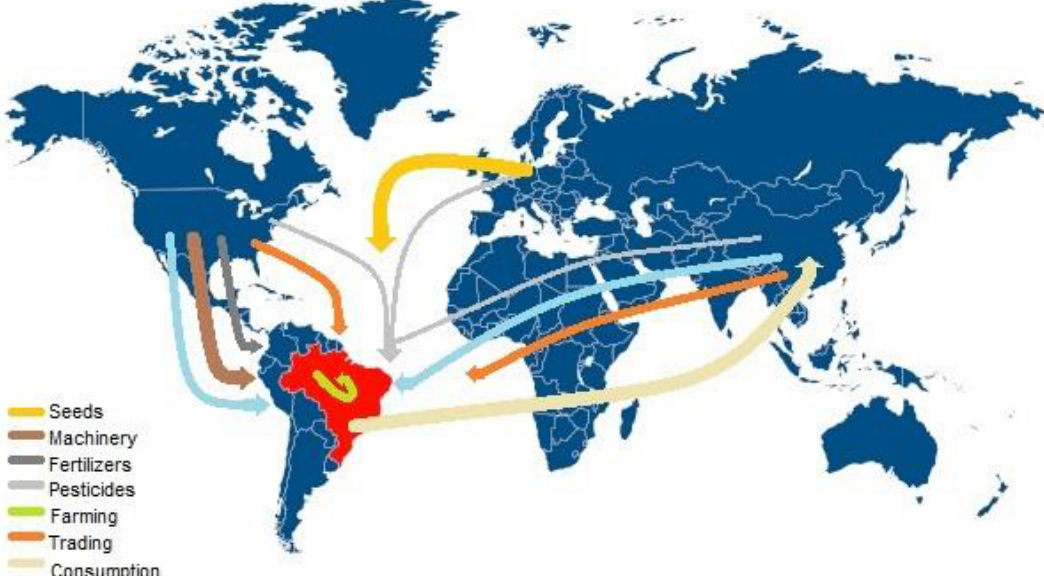
Figure 3. Home countries of companies controlling key segments of Brazil’s soybean supply chain by 2020.